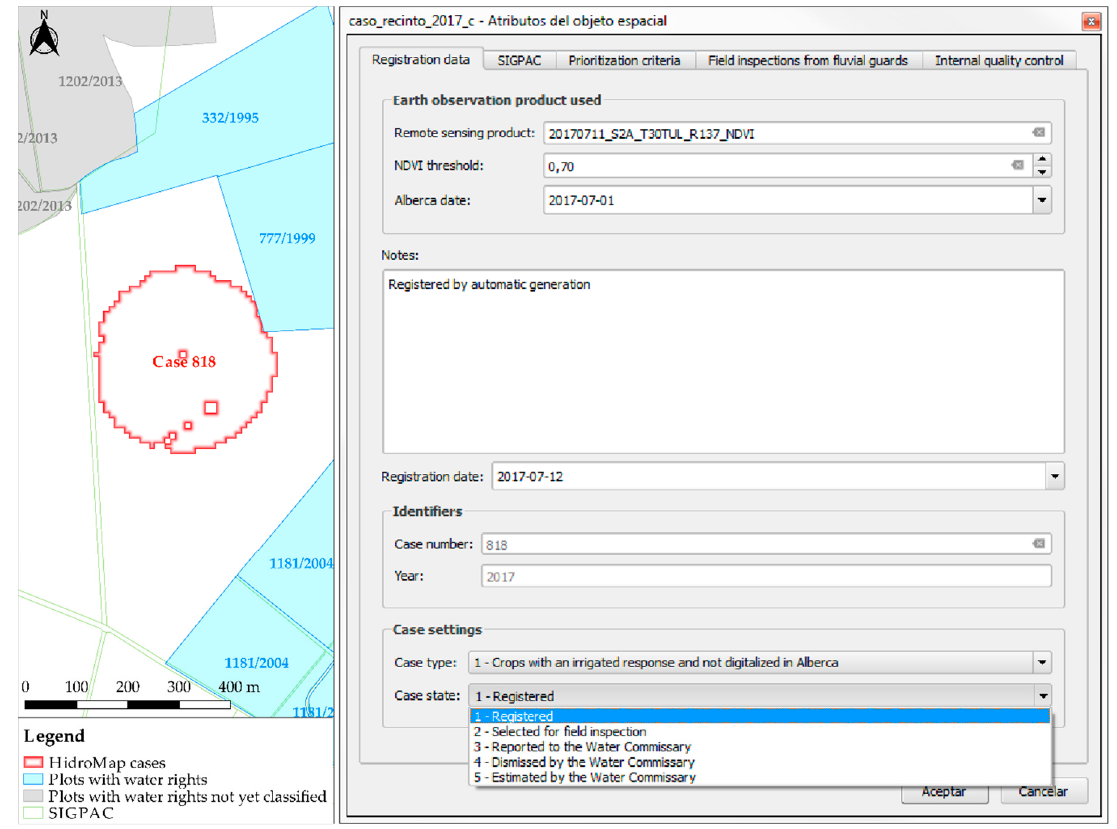
Figure 5. Crops resulted from spatial intersections of an irrigated normalized difference vegetation index (NDVI) response and layers with information of the existence of irrigation concession, SIGPAC parceling and river inspection sectors. Detection and definition of HidroMap cases and temporally monitoring of the information stored in forms.